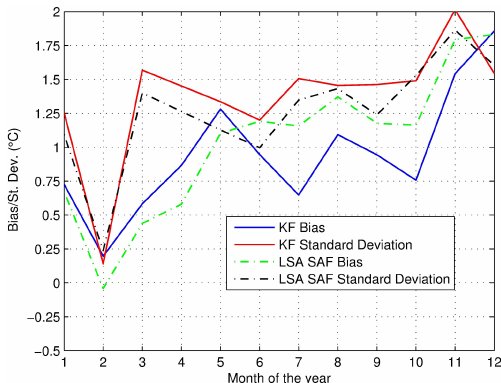
Figure 6. Evora station, year 2010. Monthly mean surface tempera- ture difference (SEVIRI–in situ) and related SD. The low values in February are due to few data points being available for this